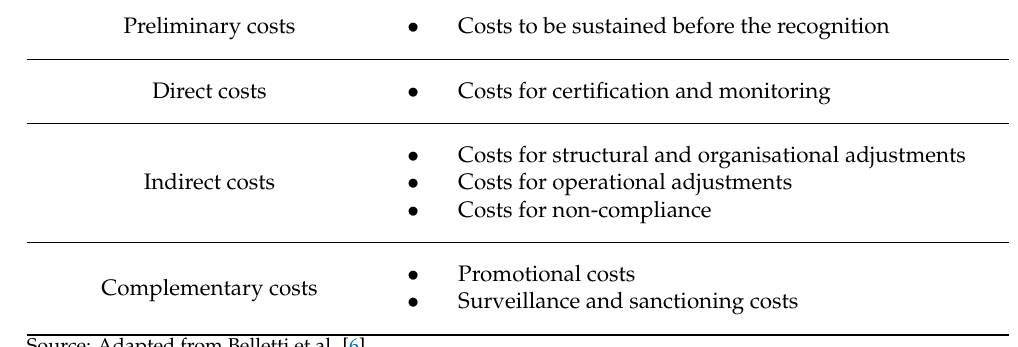
Table 1. Costs linked to the